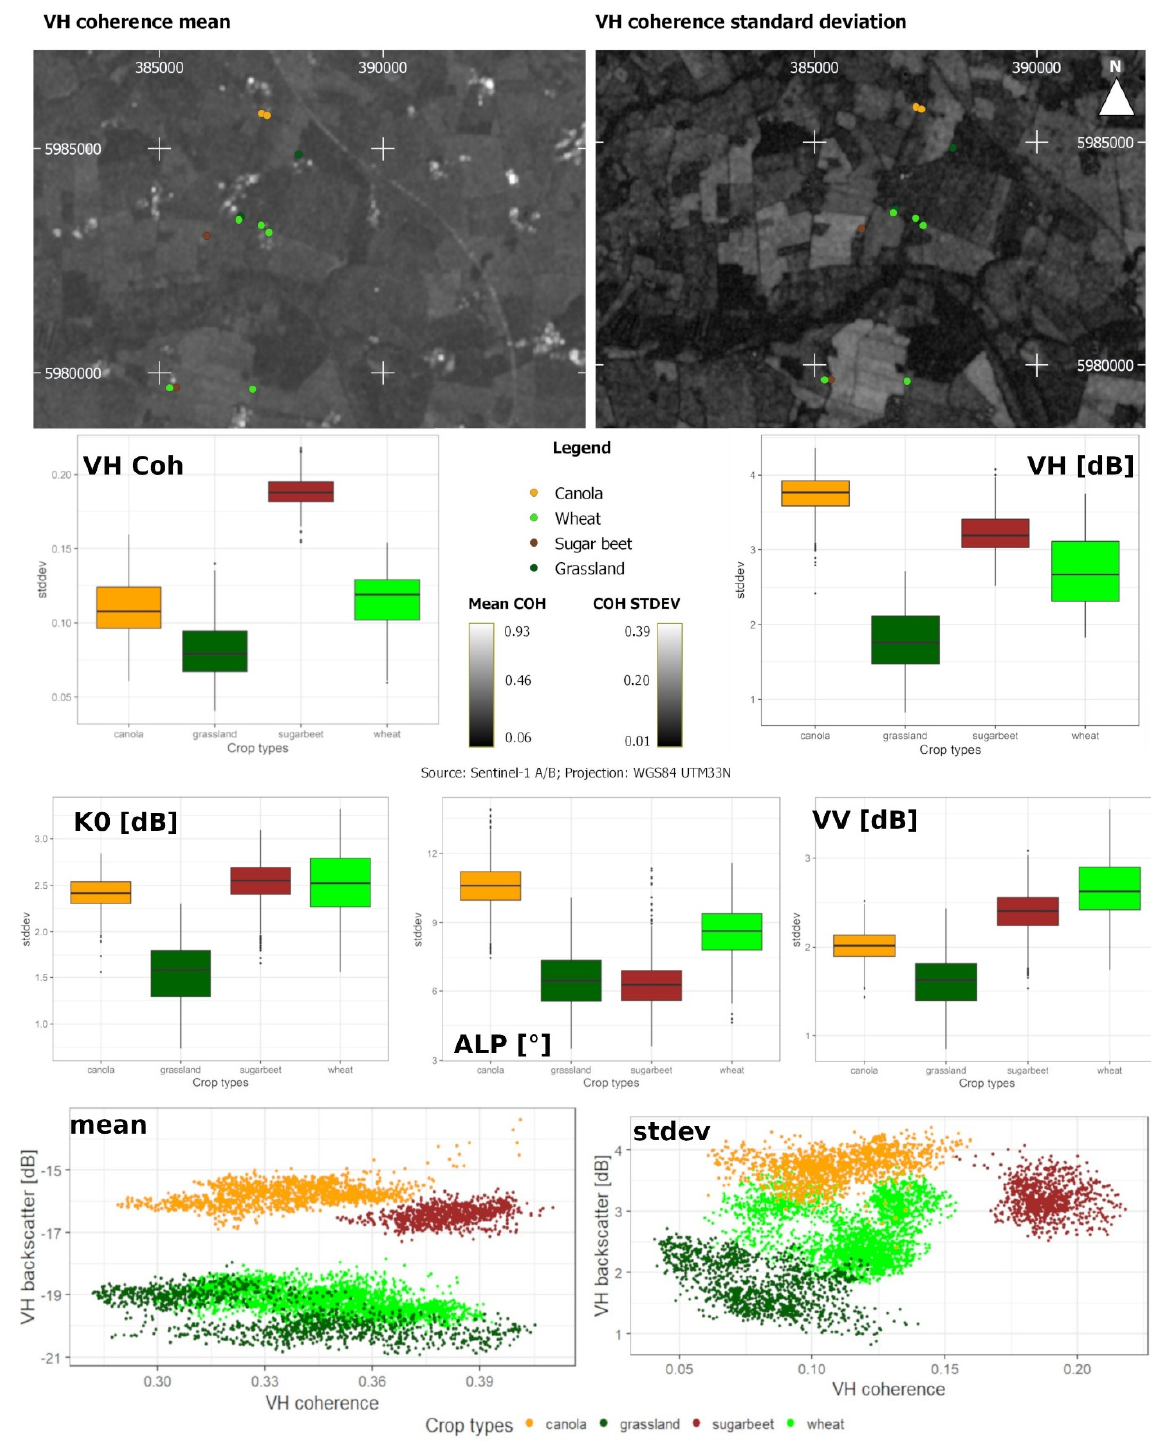
Figure 5. Crop-specific standard deviations for VV backscatter (VV [dB]), VH backscatter (VH [dB]), VH coherence (VH Coh), Alpha (ALP [°]), and K0 [dB] for canola (orange), grassland (dark green), sugar beet (brown), and wheat (green), as well as VH coherence mean and standard deviation [dB], and a subset of the original measurement points as a background image.